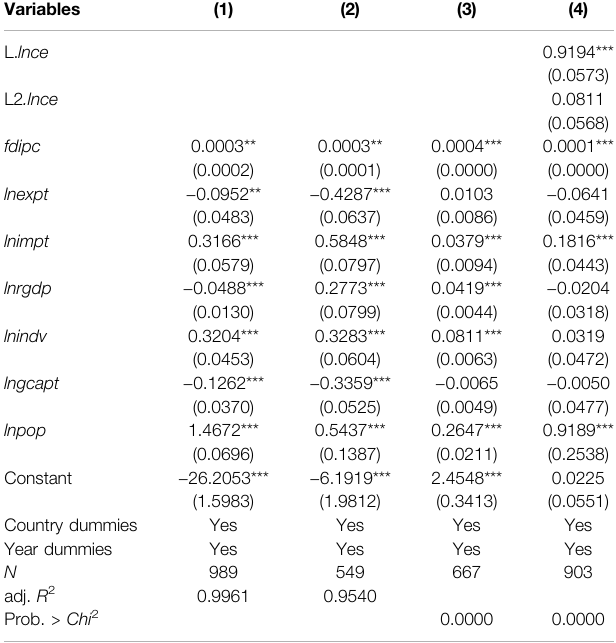
TABLE 3 | Results of robustness